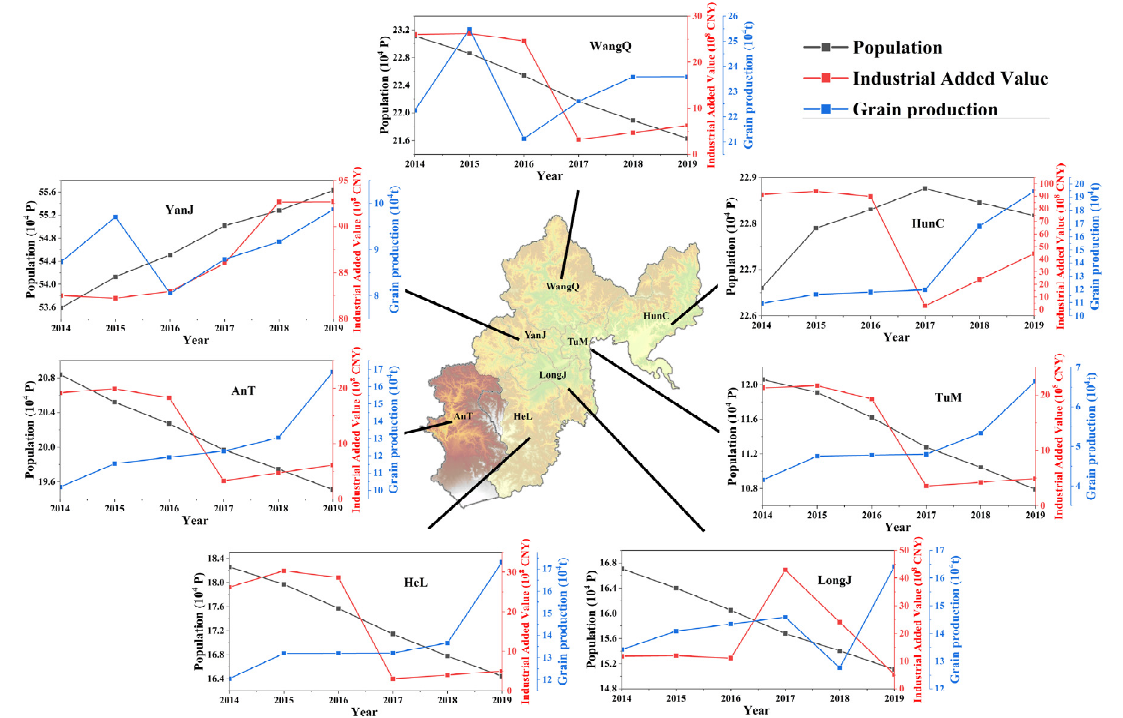
Figure 3. Socio-economic situation of the TRB from 2014 to 2019.